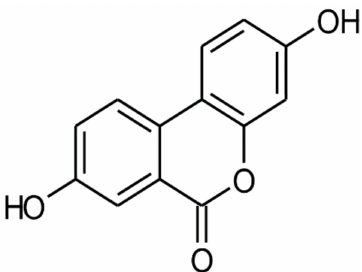
Figure 1. Chemical structure of compound Urolithin